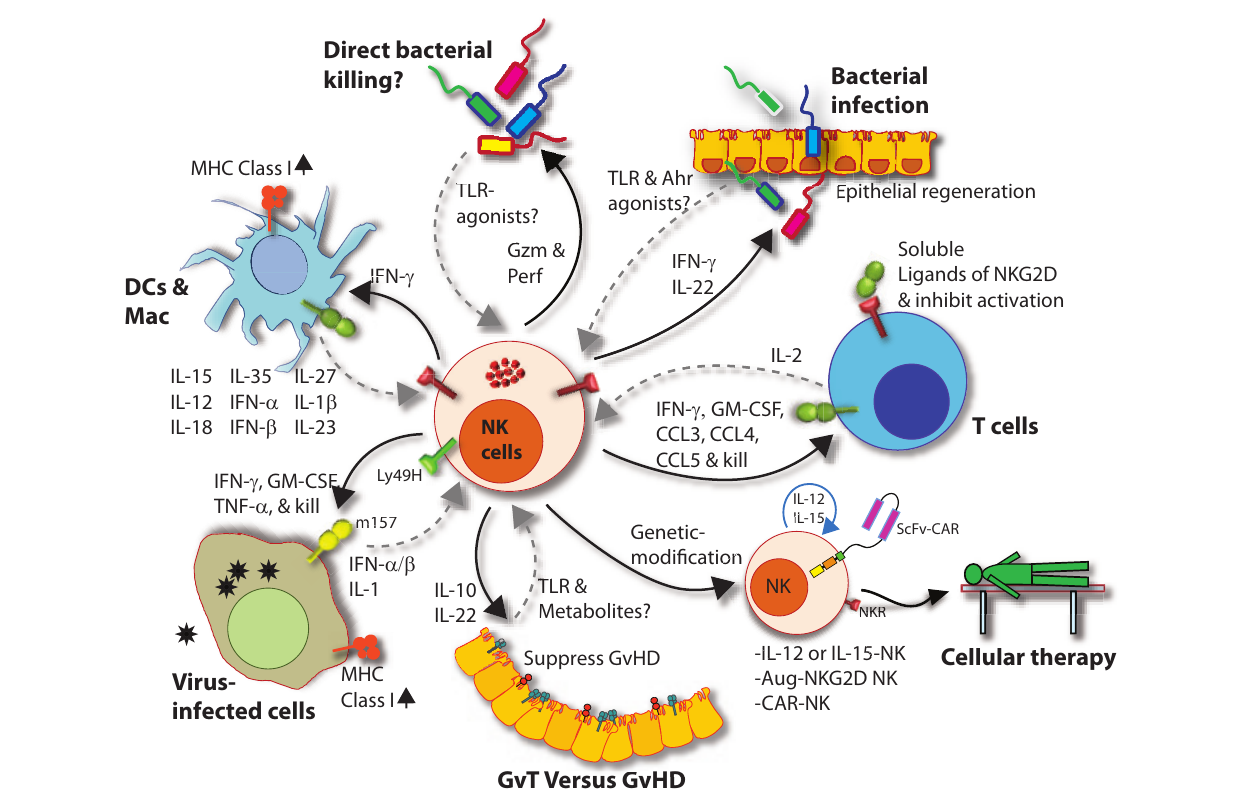
FiGURe 9 | Natural killer (NK) cells in health and disease. As the largest lymphocyte population representing innate immunity, NK cells perform diverse functions. Through their ability to mediate killing and to produce soluble factors, NK cells perform multitudes of immunological functions. Counter-clockwise: